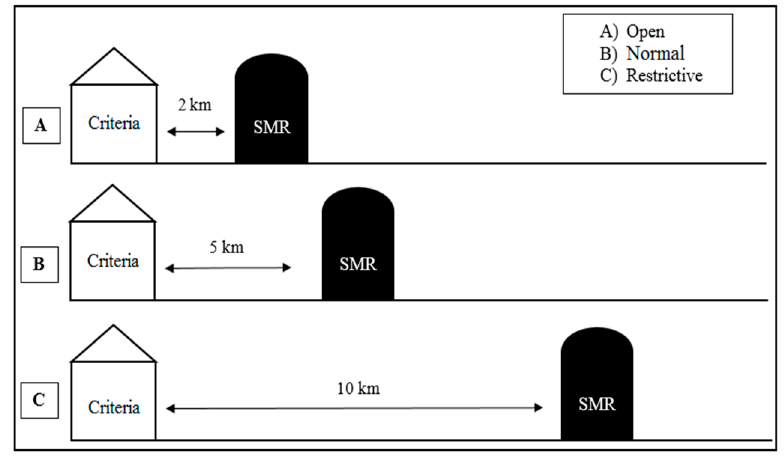
Figure 4. Comparison of siting cases for SMRs.